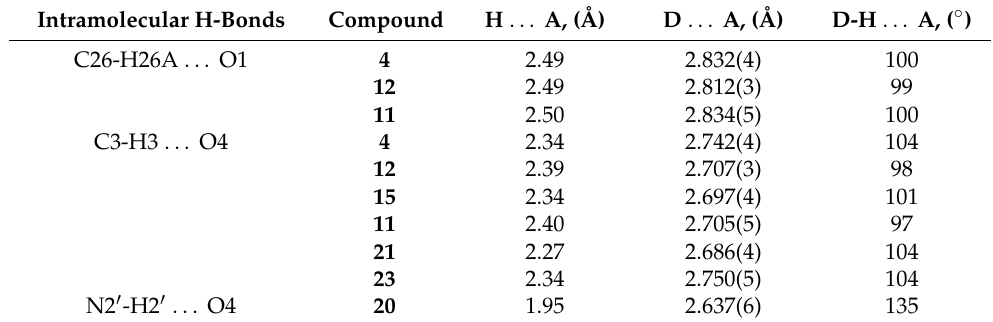
N2 (cid:48) -H2 (cid:48) . . . O4